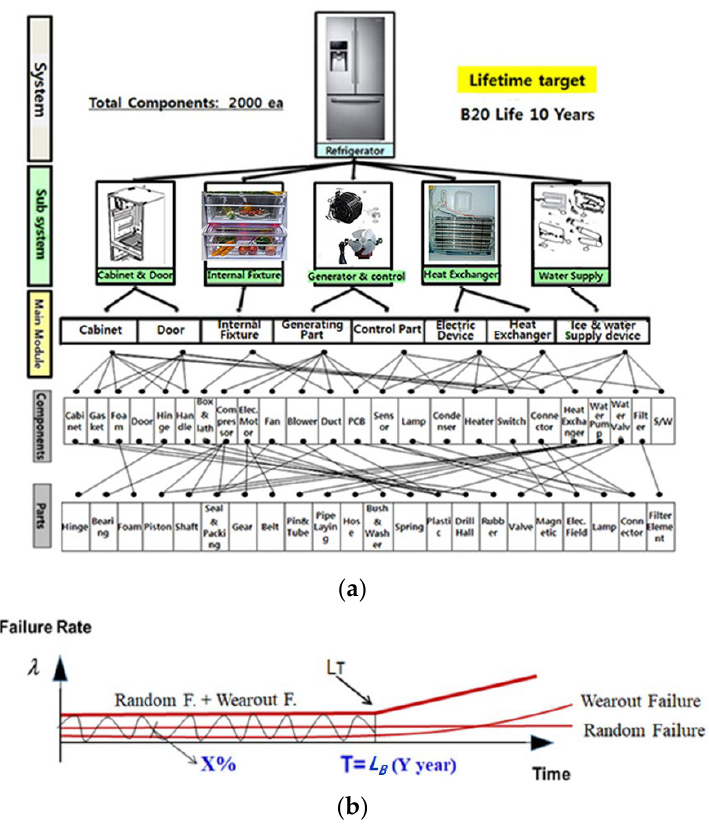
Figure 1. System life resolved by new subsystem (or module): ( a ) a systematic classes of multi-module refrigerator; ( b ) product life L B